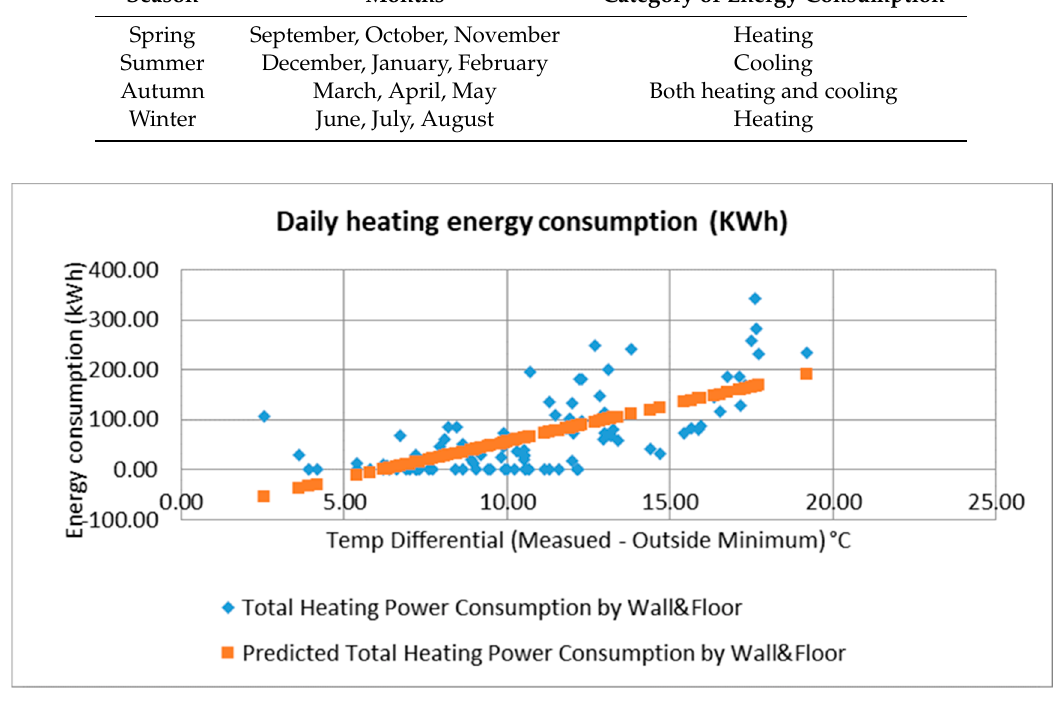
Figure 6. Comparison of heating energy consumption and temperature differentials. Daily heating energy consumption vs. temperature differential (outside minimum—measured in the greenhouse).